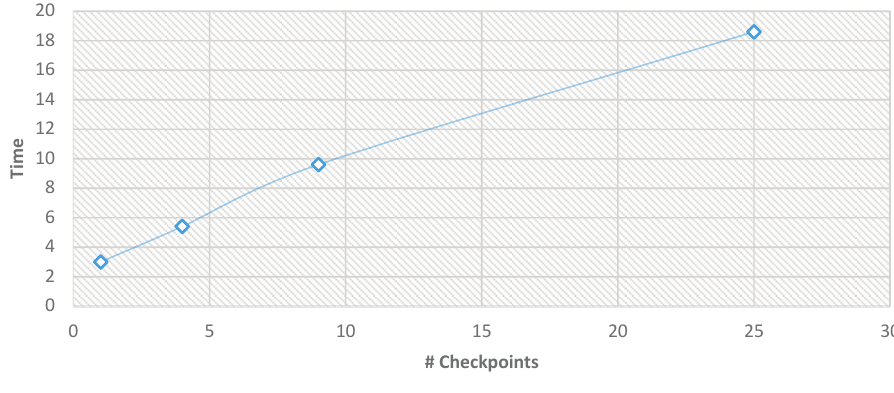
Figure 4. Number of checkpoints vs. round trip